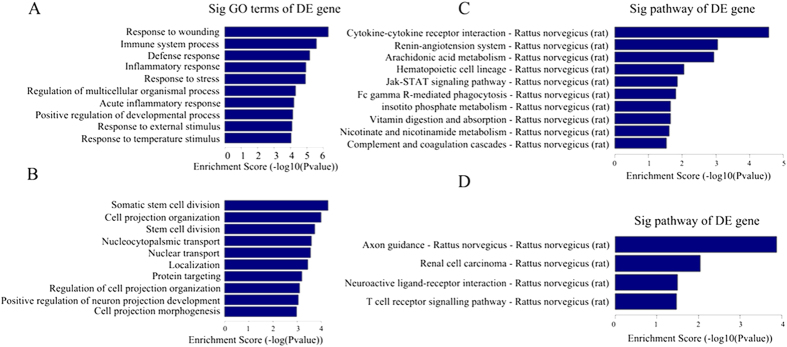
GO enrichment and KEGG pathway analysis of differentially expressed genes in HI brains according to biological processes.(A) Top 10 GO terms enriched among upregulated genes. (B) Top 10 GO terms enriched among downregulated genes. (C) The top 10 pathways enriched among the upregulated mRNAs in HI brains. (D) All pathways enriched among the downregulated mRNAs in HI brains. The bar plot depicts the enrichment scores. The P value indicates the significance of the correlation between the pathway and HIBD.